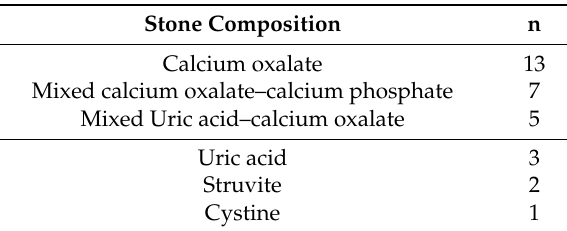
Table 3. Chemical compositions of 31 stones.